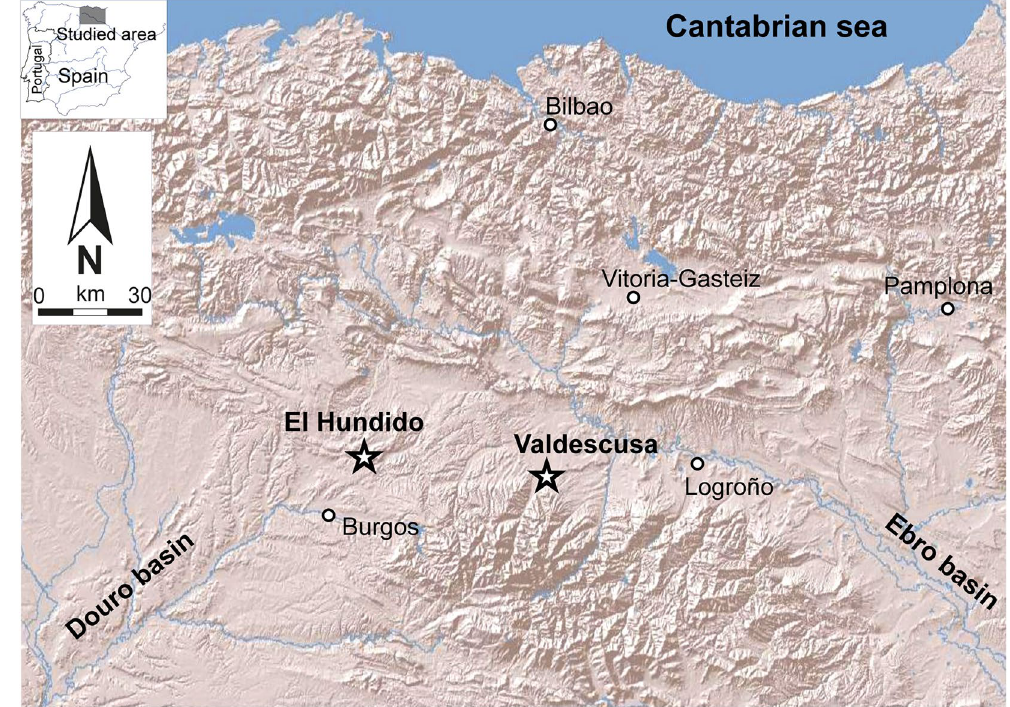
Figure 1. The geographical location of Valdescusa and El Hundido sites. Modified from Instituto Geológico y Minero de España (IGME). http:// info. igme. es/ visor web/. Original copyright Geological Survey of Spain (IGME), under CC-BY license with permission from Instituto Geológico y Minero de España